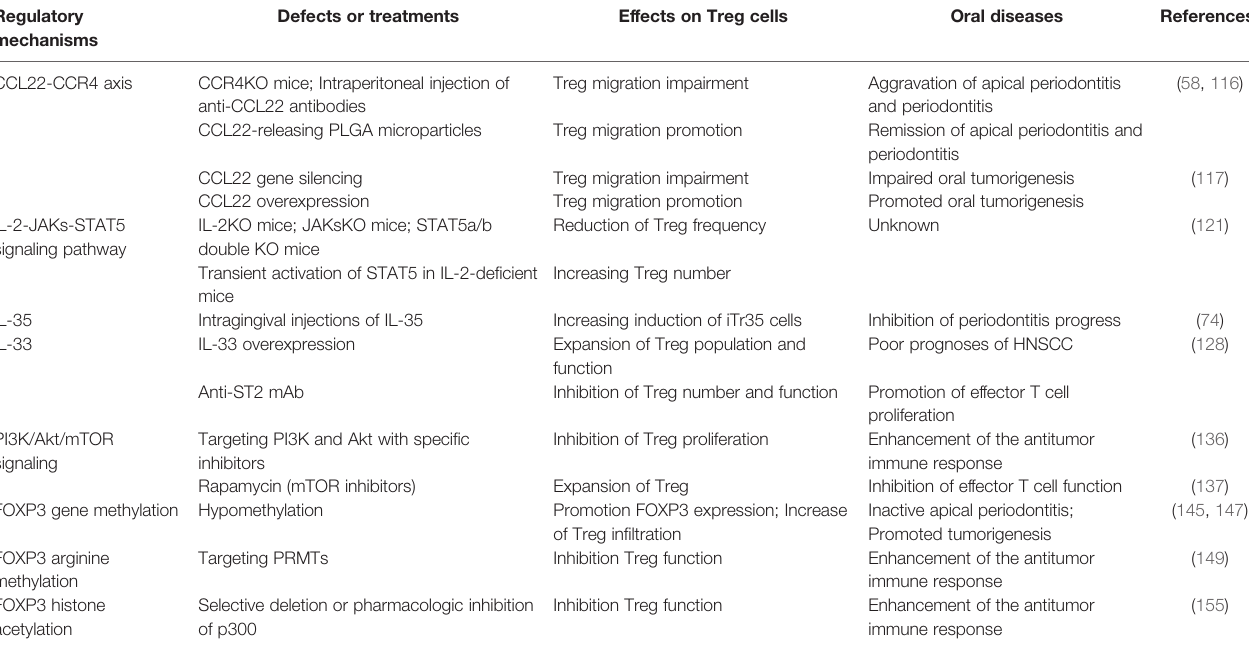
TABLE 1 | Regulatory mechanisms of Treg cells recruitment, proliferation, and function in oral diseases. Regulatory